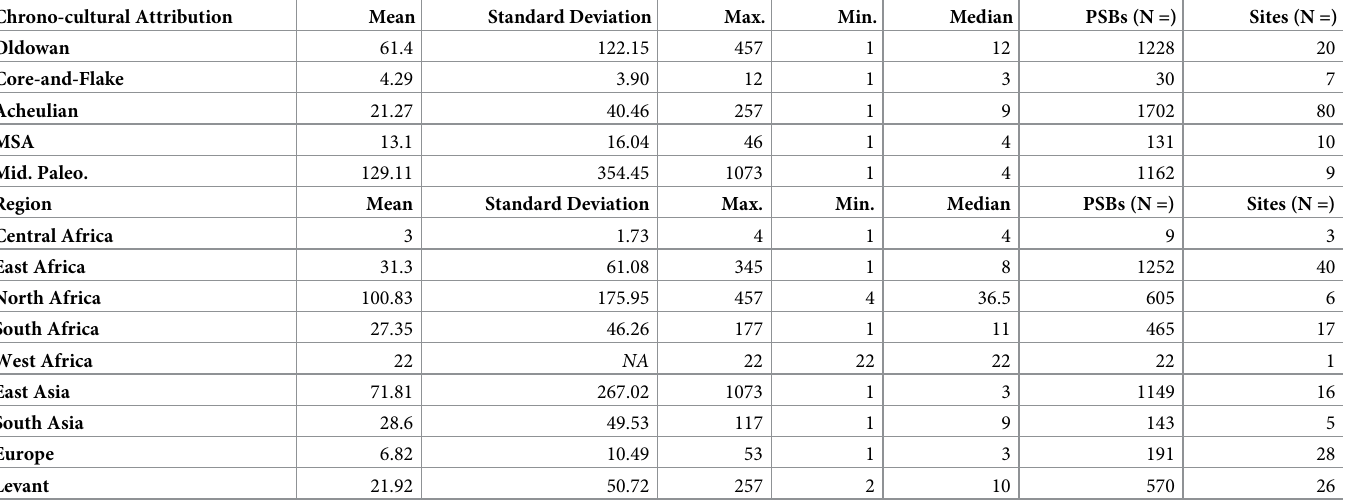
Table 2. Statistics regarding quantities of PSBs per site, according to regions and chrono-cultural attributions. Chrono-cultural Attribution